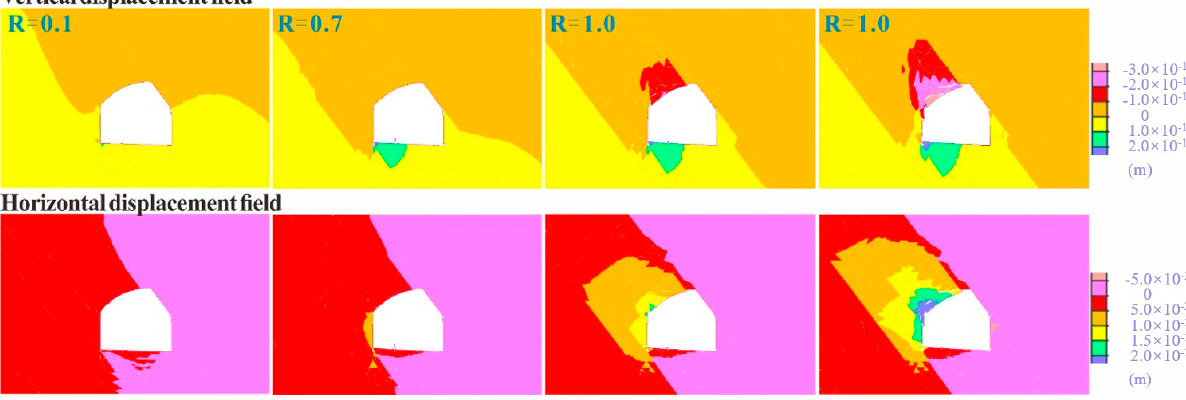
( b ) Figure 10. Differential evolution laws of cracks in surrounding rocks. ( a ) Zonal distribution charac- teristics of cracks; ( b ) time-dependent evolution curves of cracks. 3.2.4. Analysis of Time-Dependent Failure Mechanism It can be concluded from the simulation results and field observations that the defor- mations of the surrounding rocks of the roadway in the steeply inclined coal seam are highly correlated with time and subject to the zonal differential evolution law, which is mainly reflected in the deterioration rate of the surrounding rocks on the arc roof side far